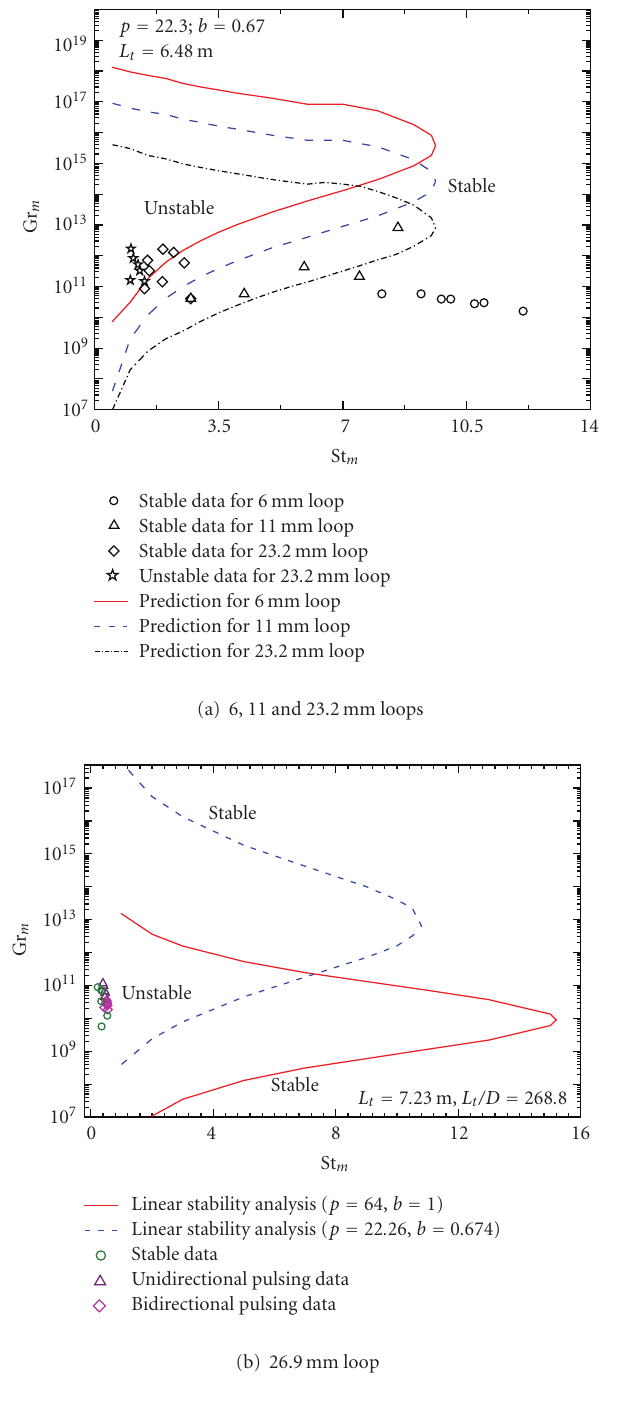
Figure 5: Comparison of predicted stability map with